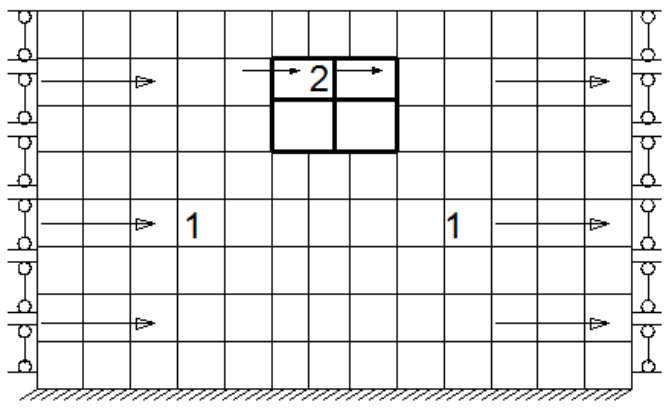
Figure 3. DESANM calculation